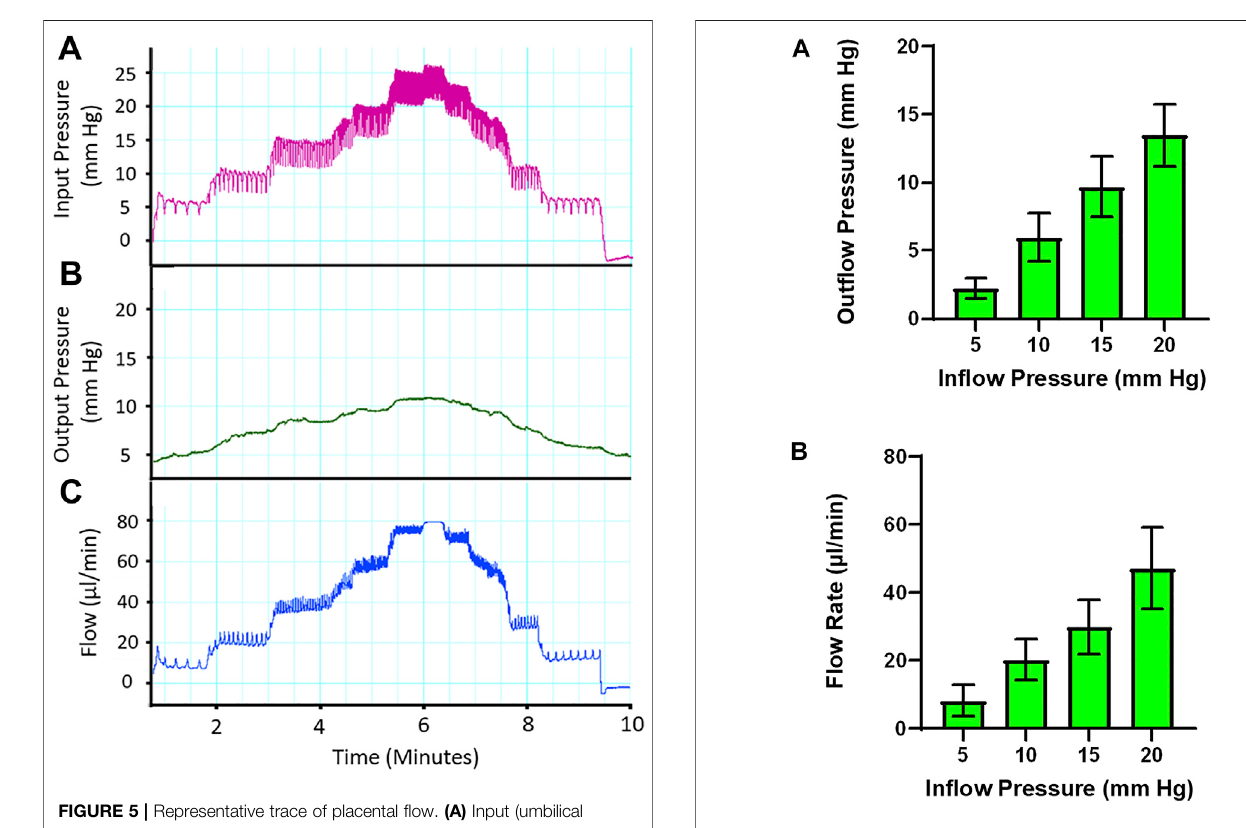
FIGURE 6 | Out fl ow pressure and fl ow rate across in fl ow pressures. (A) As in fl ow pressure is increased in a stepwise fashion out fl ow pressure increases with both normal superfusate. (B) Alternatively, fl ow rate can be measured as the result of increasing in fl ow pressure. ( n = 3